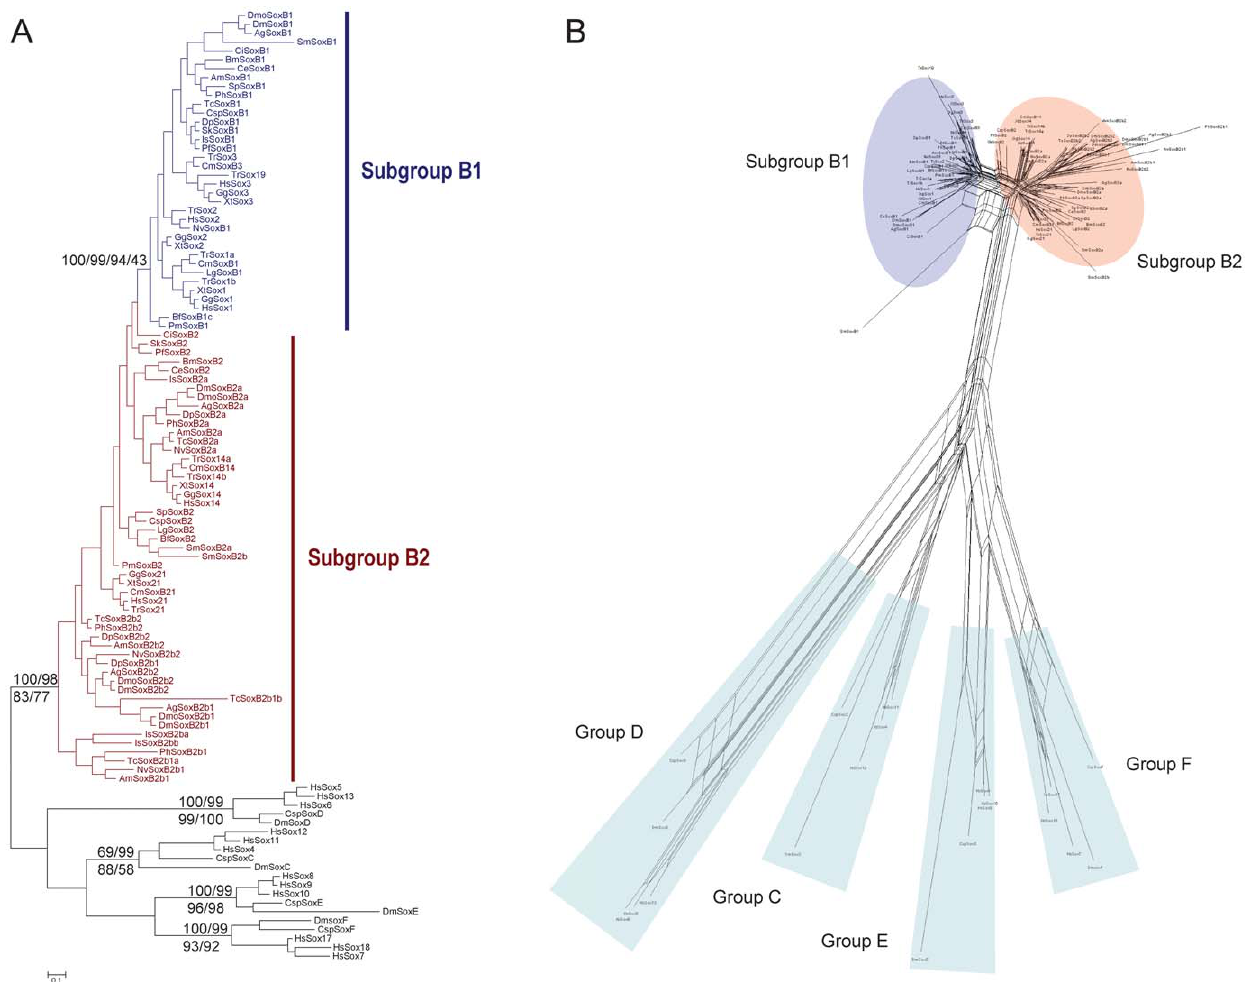
Figure 6. Phylogenetic tree and split network of the bilaterian SoxB1/B2 proteins based on the HMG domain alignment with sequences from Sox groups C, D, E, and F of the human, Drosophila , and annelid. (A) Bayesian tree is shown. Statistical support values for the important nodes were derived with different methods, as described in Fig. 3. The model for the Bayesian reconstruction was RtREV + I + G; the model for the ML reconstruction was LG + I + G. (B) Split network based on the data used in (A) excluding TcSoxB2b1a, TcSoxB2b1b, IsSoxB2ba, and IsSoxB2bb, under the JTT model. Abbreviations of species names are as in Table 1.